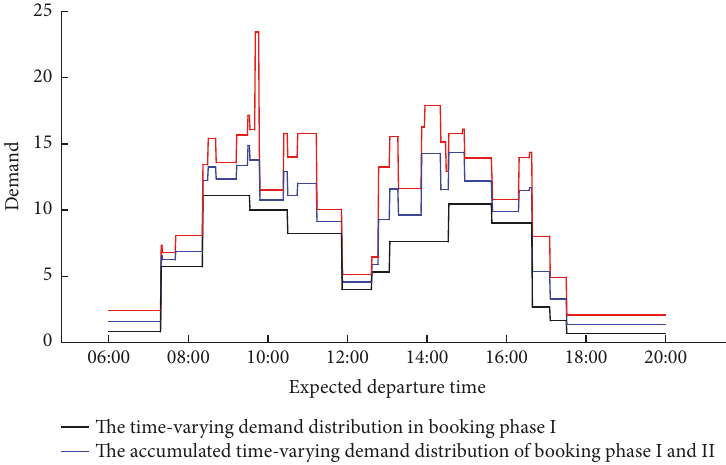
The time-varying demand distribution in booking phase I The accumulated time-varying demand distribution of booking phase I and II The accumulated time-varying demand distribution of booking phase I, II and Figure 14: The accumulated time-varying demand distribution of the MBPRA algorithm.